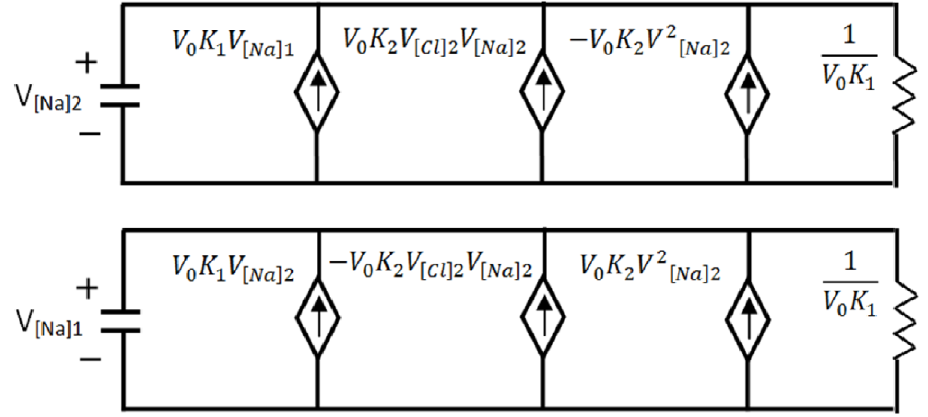
Figure 12. The analogous electrical circuits of concentrations [Na + ] the flow through cell’s membrane.